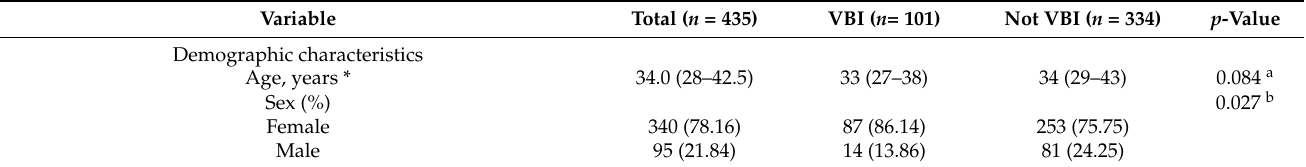
Figure 2. Humoral response kinetics to the inactivated SARS-CoV-2 BBIBP-CorV vaccine, determined up to 210 days after the second dose, in healthcare workers with and without vaccine breakthrough infection: ( a ) Antibody neutralization cPass™ after the second dose of BBIBP-CorV vaccination. ( b ) Titers of Elecsys ® anti-SARS-CoV-2 S after the second dose of BBIBP-CorV vaccination. Humoral response between healthcare workers with and without booster BNT162b2, determined up to 210 days after the second dose of BBIBP-CorV: ( c ) antibody neutralization cPass™; ( d ) titers of Elecsys ® anti-SARS-CoV-2 S. Humoral response between healthcare workers previously and not previously infected, determined up to 210 days after the second dose of BBIBP-CorV; ( e ) antibody neutralization cPass™; ( f ) titers of Elecsys ® anti-SARS-CoV-2 S. Humoral response of healthcare workers with and without a history of infection after the second dose of BBIBP-CorV with or without booster BNT162b2; ( g ) antibody neutralization cPass™ after the second dose of BBIBP-CorV vaccination; ( h ) titers of Elecsys ® anti-SARS-CoV-2 S after the second dose of BBIBP-CorV vaccination. ns = p ≥ 0.05; ** = p < 0.05; *** = p < 0.001; **** = p < 0.0001. Table 1. Demographics, characteristics and humoral response rates of the study population, and comparison between healthcare workers with and without a COVID-19 booster dose in vaccine breakthrough